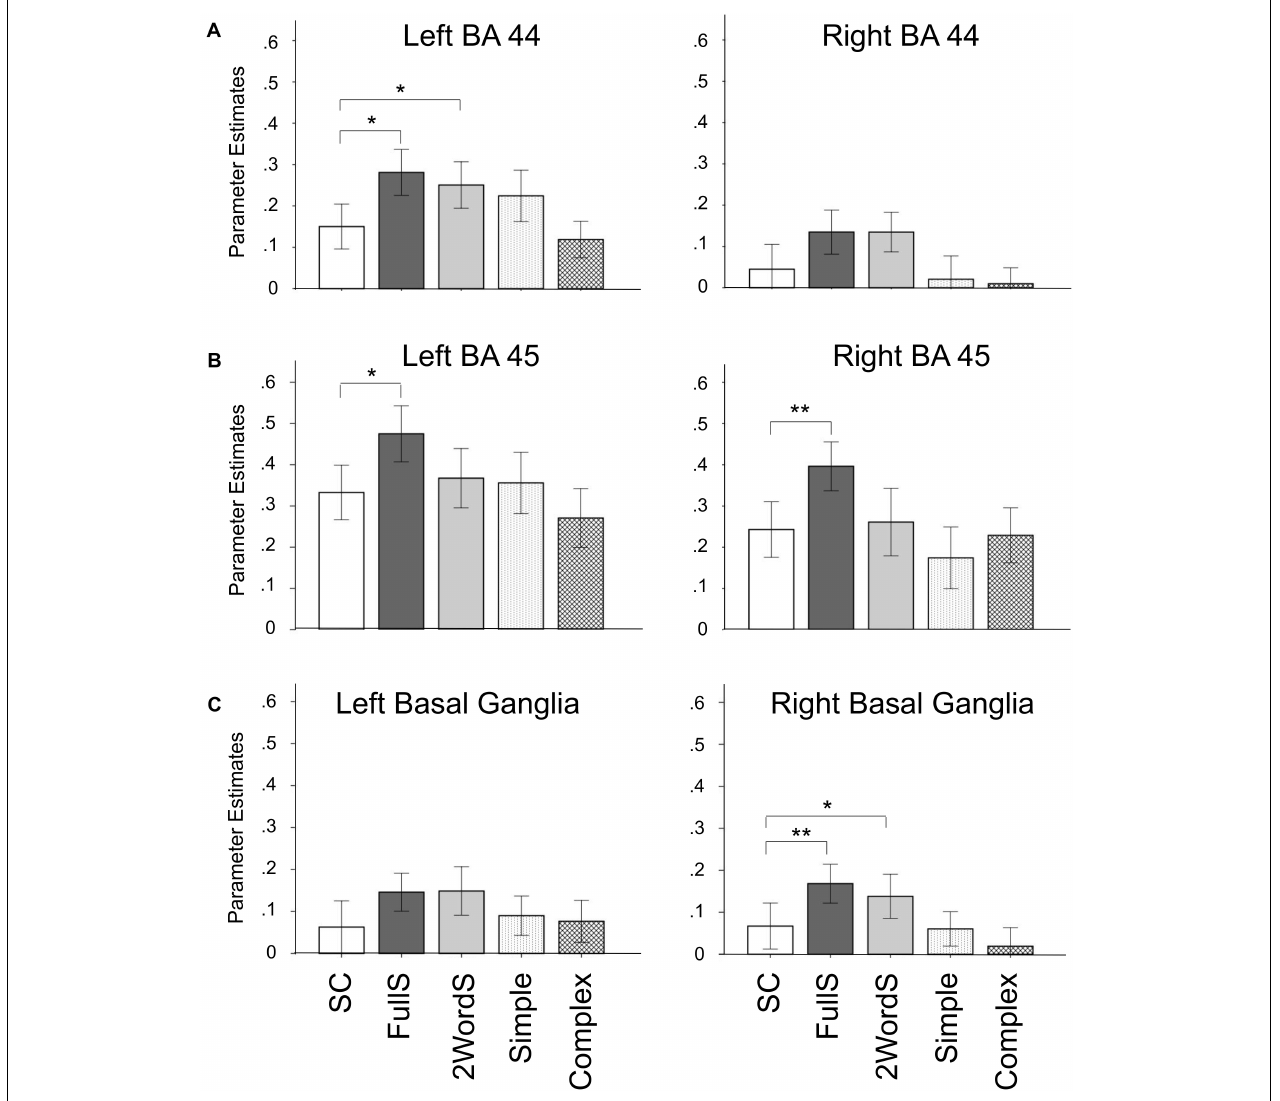
FIGURE 4 | Reduced activation for Small Clause in anatomically defined syntax-related regions of interest. Parameter estimates per condition were extracted from 6 anatomically defined regions of interest and average group parameter estimates are shown by condition in bilateral BA 44 (A) , BA 45 (B) , and Basal Ganglia (C) . ∗ p < 0.05; ∗∗ p < 0.02; SC, Small Clauses; FullS, Full Sentences; 2WordS, Two-word Control Sentences; Simple, Simple Compounds; Complex, Complex